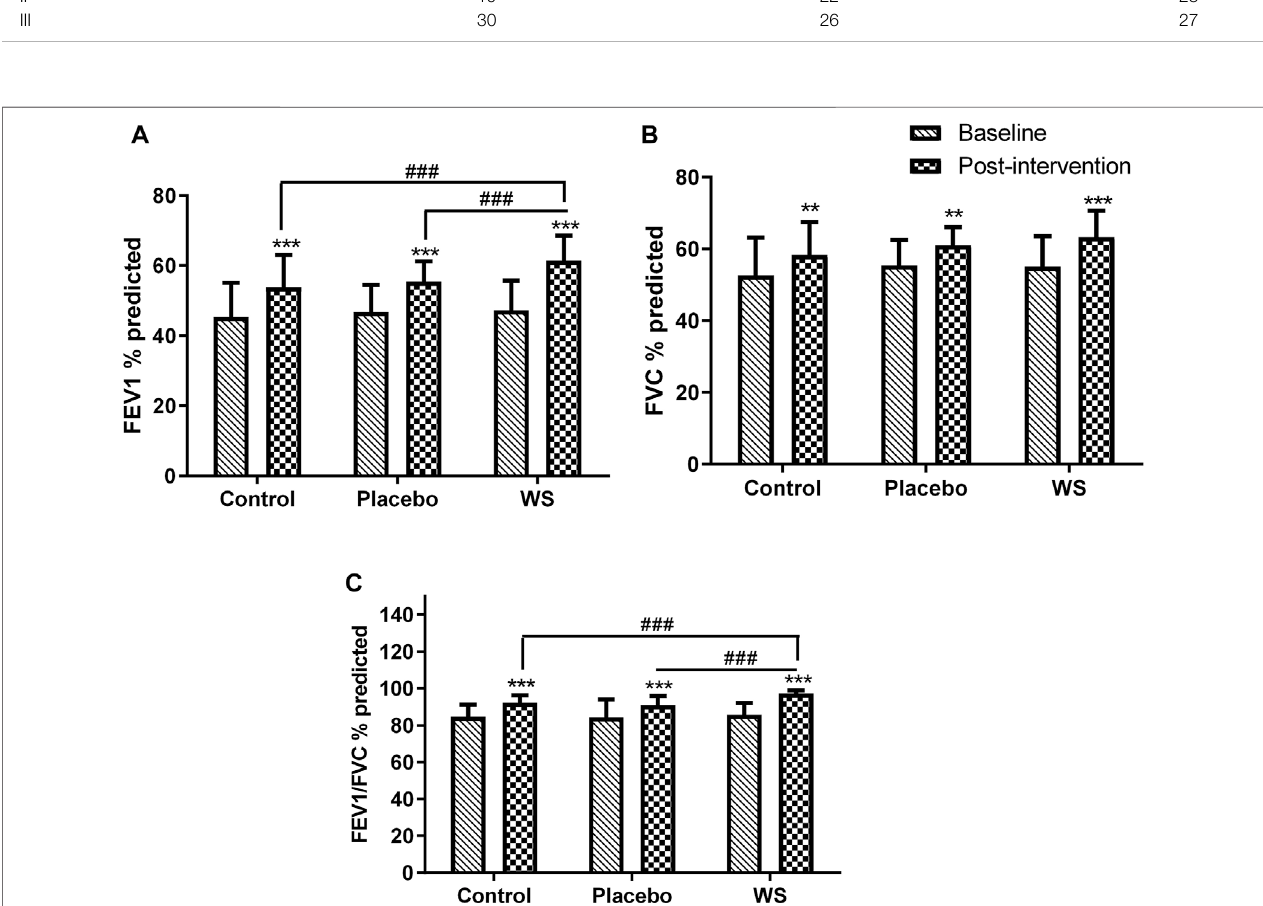
FIGURE2| Lungfunctionbeforeandafterintervention:Mean (A) FEV 1 %predicted, (B) FVC%predicted,and (C) FEV 1 /FVC%predictedvaluesatthebaselineand at the end of the study. * p ≤ 0.05, ** p ≤ 0.01, and *** p ≤ 0.001 compared with their respective baselines. ### p ≤ 0.001.